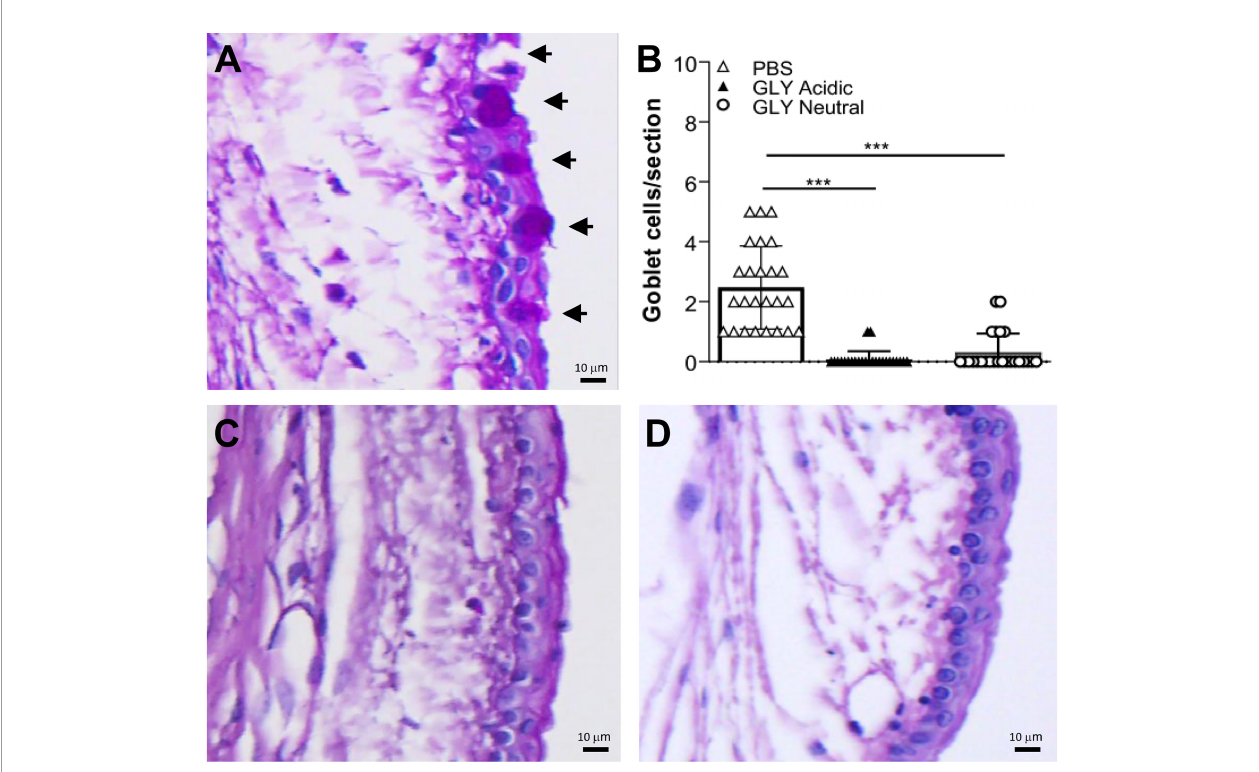
FIGURE 1 | Bulbar goblet cells (arrows) in normal conjunctiva (no corneal wound) in eyes that received topical application of PBS (A) , or acidic (C) , or neutral GLY (D) for 4 days and tested on day 5. Acidic (C) or neutral GLY (D) vs . PBS (A) showed signi fi cantly reduced goblet cell number (B) on day 5. Data are expressed as mean ± SEM (***p < 0.001, n = 3/group). Scale bar = 10 m